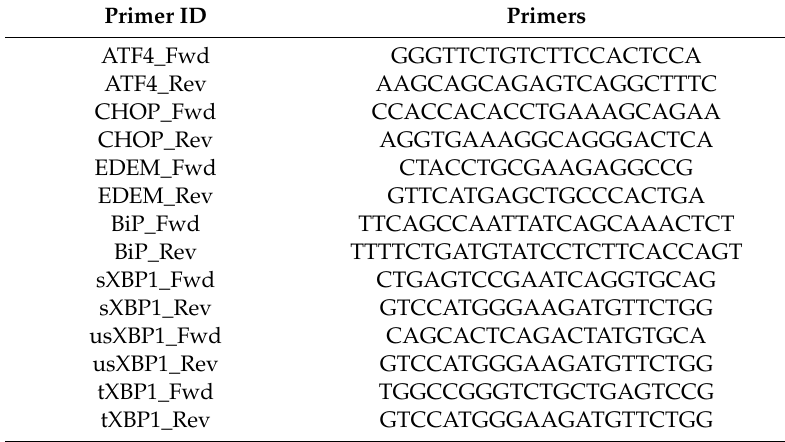
Table 2. List of primers used by real-time qPCR to detect endoplasmic reticulum (ER) stress